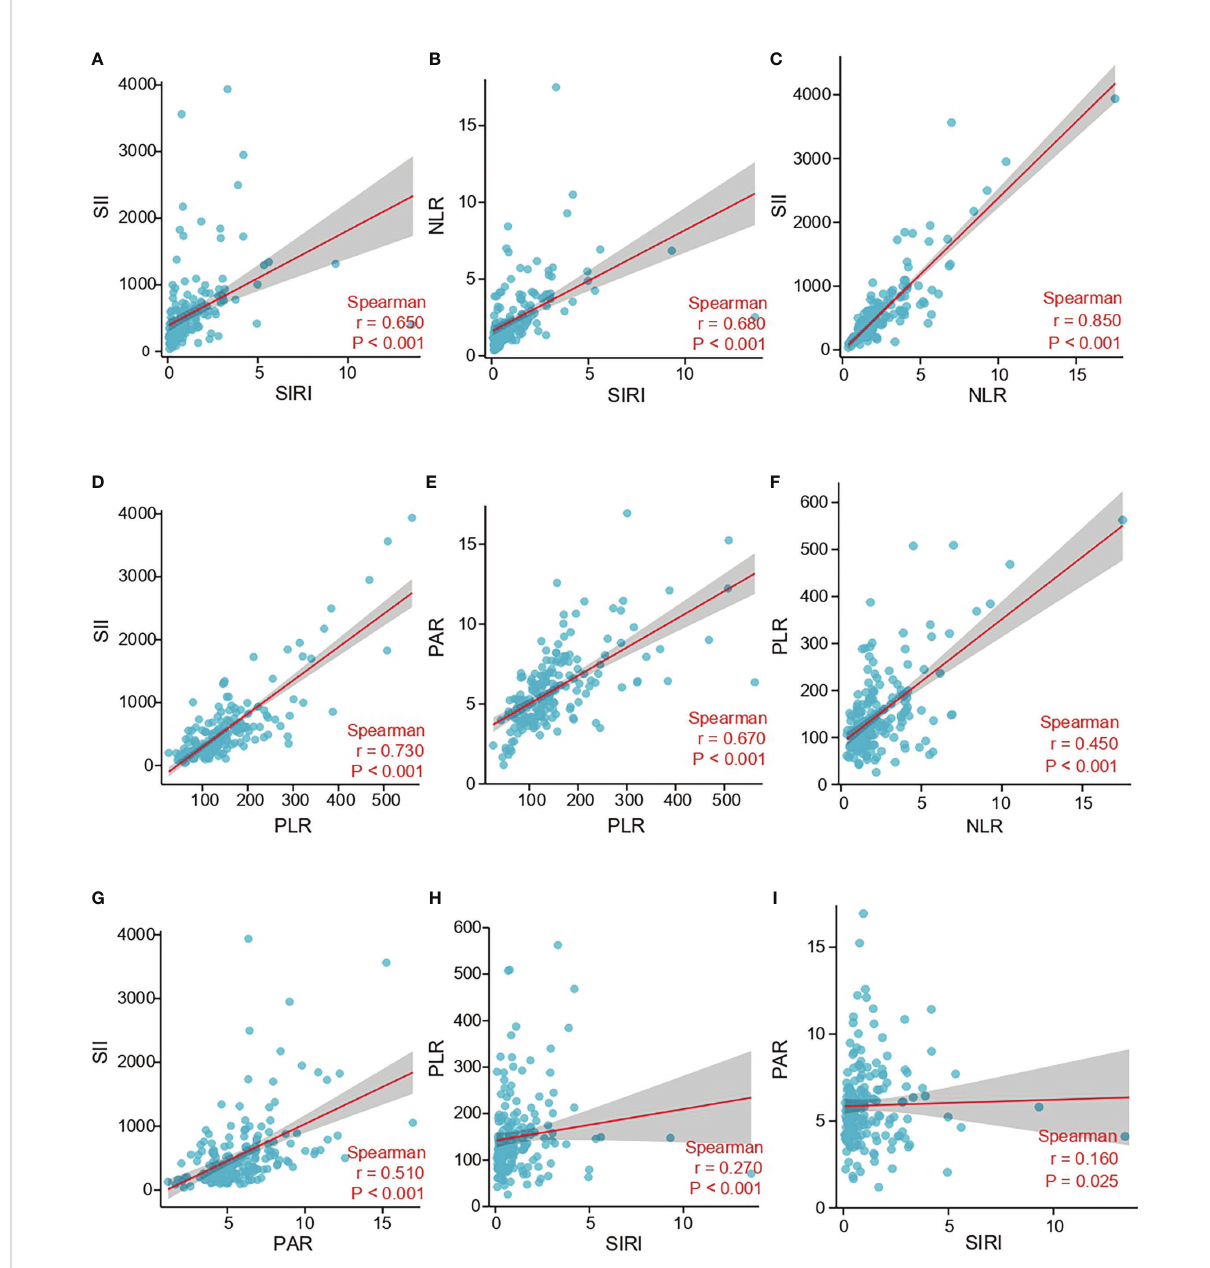
FIGURE 3 Correlation between SII, SIRI, NLR, PLR and PAR in the study cohort. (A) The correlation between SII and SIRI. (B) The correlation between NLR and SIRI. (C) The correlation between SII and NLR. (D) The correlation between SII and PLR. (E) The correlation between PAR and PLR. (F) The correlation between PLR and NLR. (G) The correlation between SII and PAR. (H) The correlation between PLR and SIRI. (I) The correlation between PAR and SIRI; SII, systemic immune-in fl ammation index; SIRI, system in fl ammation response index; NLR, neutrophil-lymphocyte ratio; PLR, platelets-lymphocyte radio; PAR, platelets-albumin